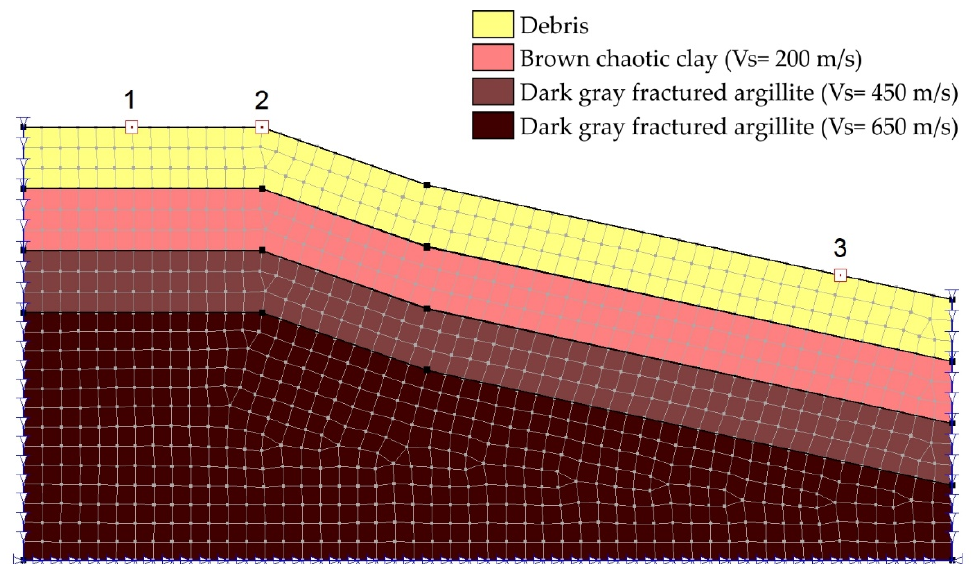
Figure 12. Cross-section and location of the three monitored points.